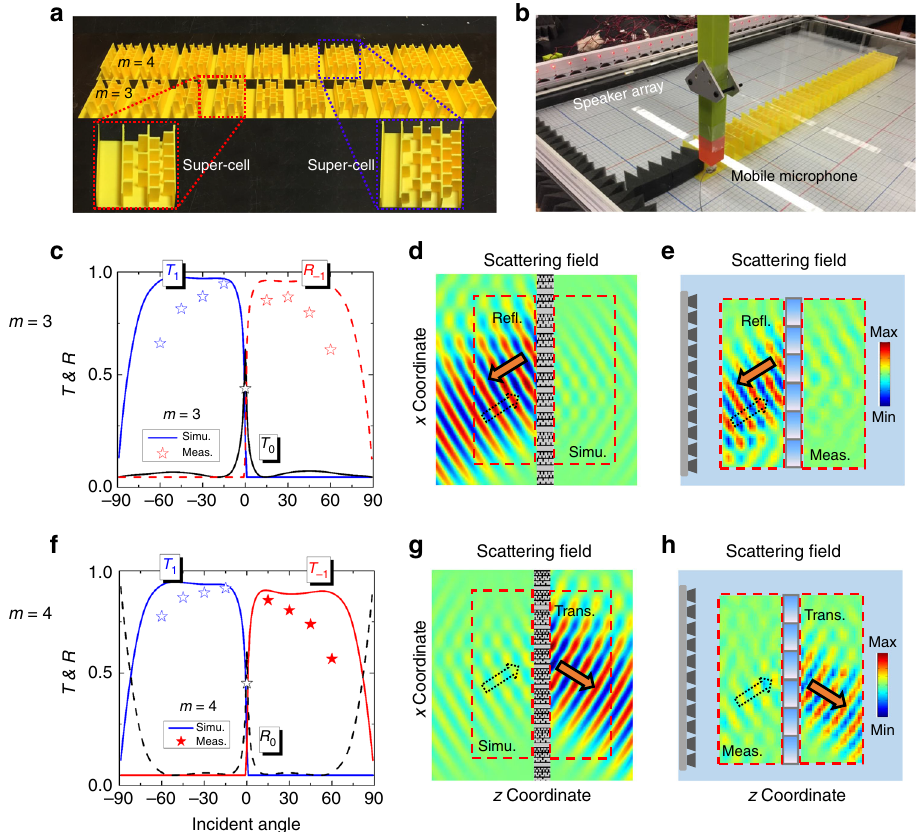
Fig. 4 Experimental setup and results. a Photograph of the fabricated samples. b Photograph of experimental setup. c The relationship between transmission/re fl ection ( T 1 , T 0 and R − 1 ) and the incident angle for the designed PGM with m = 3. d , e The simulated and measured scattered pressure fi eld patterns for incident beam with θ in = 30° bumping on the designed PGM with m = 3, respectively. f The relationship between transmission/re fl ection ( T 1 , T − 1 , and R 0 ) and the incident angle for the designed PGM with m = 4. g , h The simulated and measured scattering pressure fi eld patterns for incident beam with θ in = 30° bumping on the designed PGM with m =